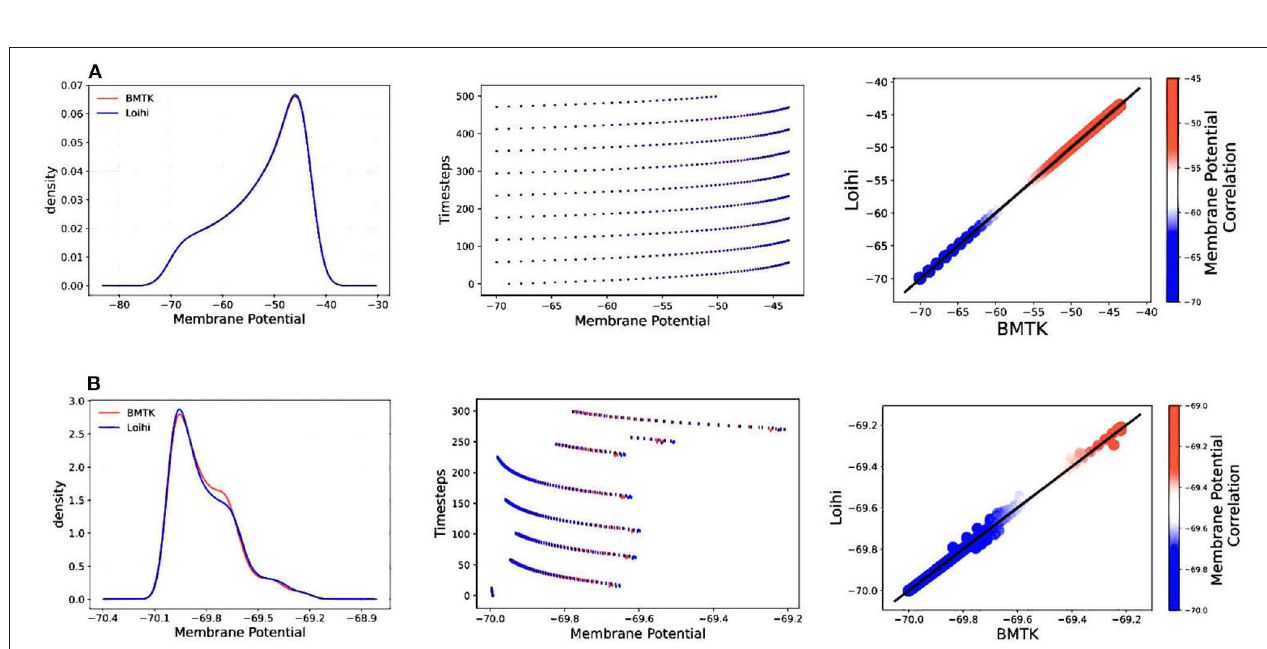
FIGURE 4 | Validation plots for simulations based on two different stimuli— (A) Validation plots for bias current stimulus (B) Validation plots for external spike stimulus, based on the Distribution Function, Raster Plot, and Scatter Plot, respectively.